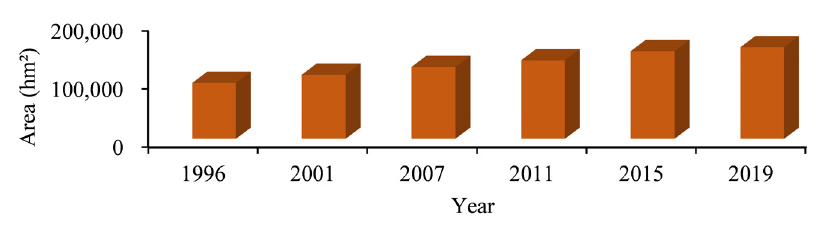
Figure 3. Time series statistic diagram of built-up land area.